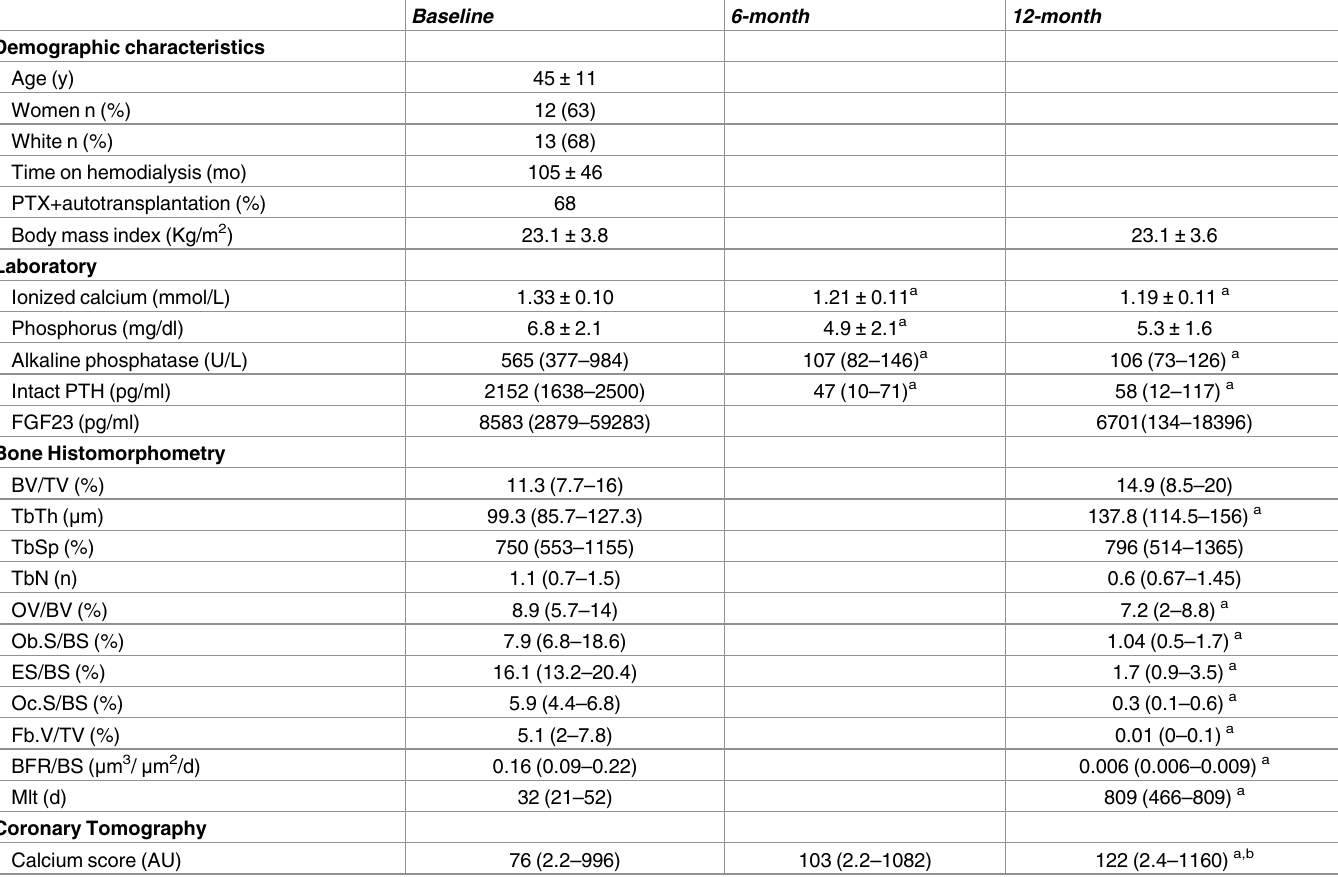
Table 1. Demographic, coronary tomography, laboratory and bone histomorphometry data of 19 patients.